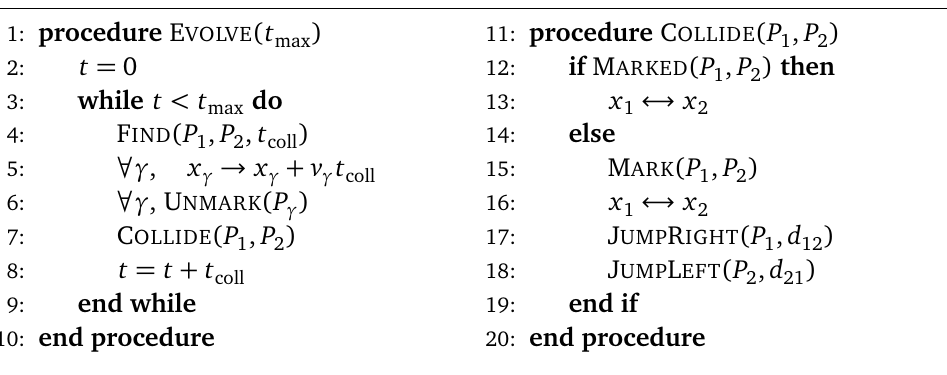
Figure 2: Flea gas dynamics. The main procedure E VOLVE evolves the system up to t . The routine F IND ( P , P , t ) finds the particles P and P that scatter first at max 1 2 coll 1 2 time t . The positions x γ of the particles are evolved up to t . v γ are the bare coll coll velocities (cf. Eq. (29)). Then, particles P and P scatter. The function U NMARK re- 1 2 moves the mark assigned to the particles when they scatter for the first time. The scat- = − d tering is implemented by C OLLIDE : P and P are displaced by a distance d 1 2 12 21 (cf. Eq. (26)). The functions J UMP L EFT and J UMP R IGHT implementing this shift are in Fig. 3. Before scattering the particles are marked. Marked particles cross each other. Note that while P is scattering with P , a scattering with a third particle P 1 2 3 can occur, initiating a scattering